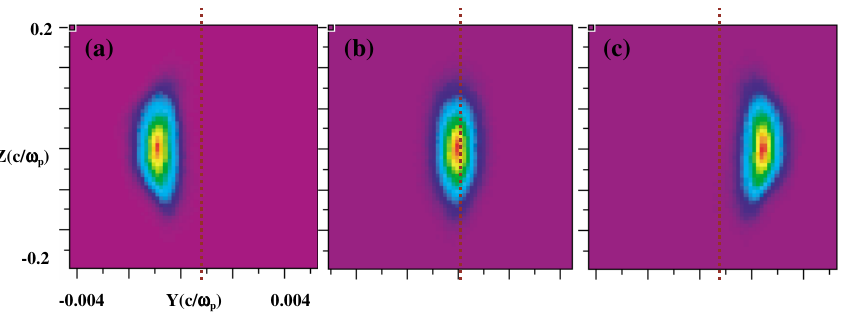
(cid:2) 0 : 4 ms (18 turns); (b) at t 0 for all the snapshots is 1.67 m. p